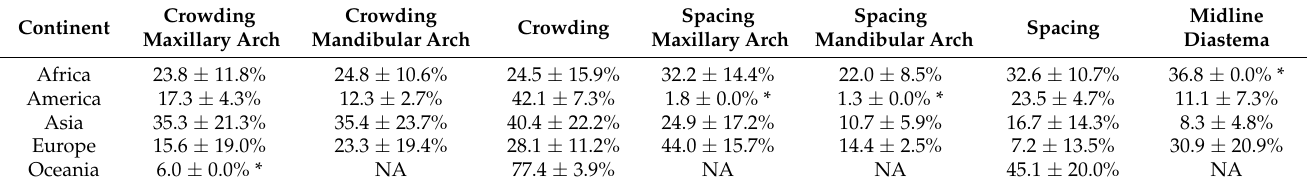
Table 7. Prevalence of space anomalies according to geographical